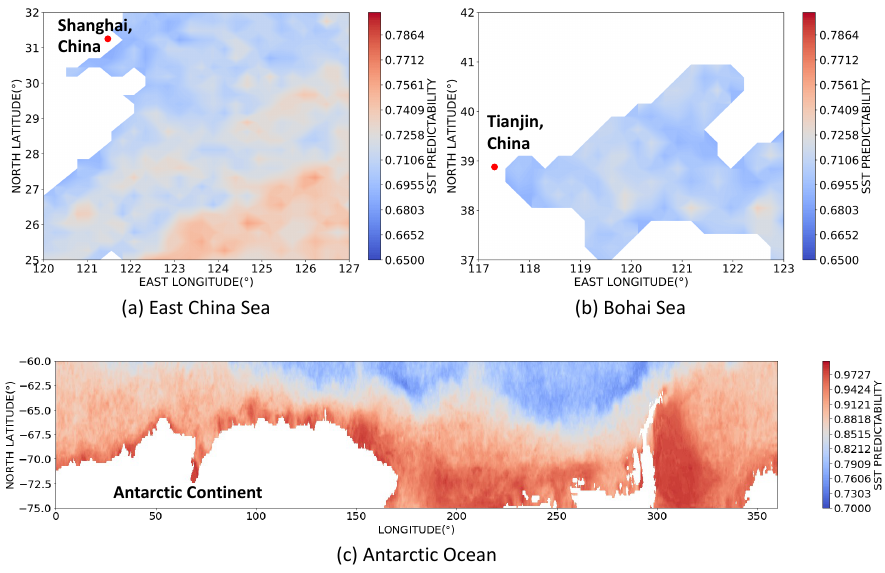
Figure 9. The predictability of SST in the ( a ) East China Sea, ( b ) the Bohai Sea, and ( c ) the Antarctic Ocean within 20 years from 2002 to 2021.